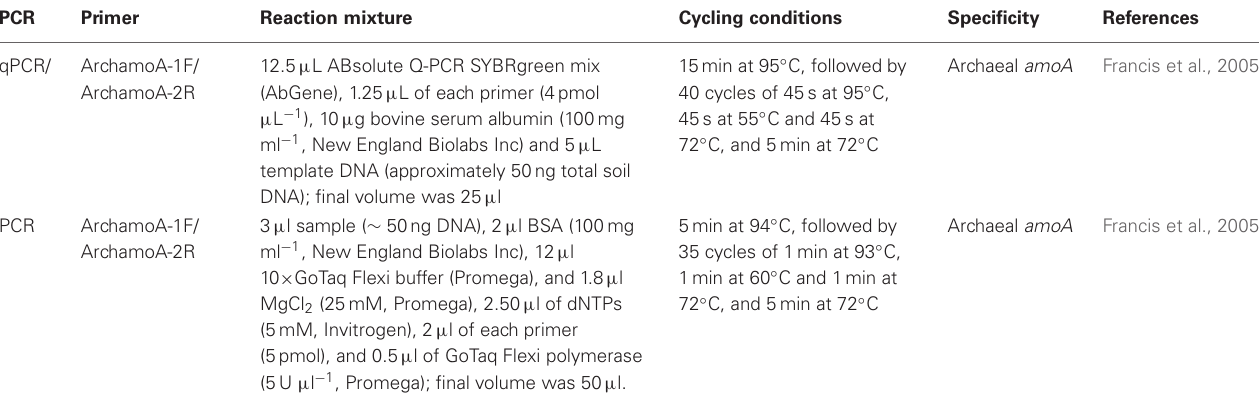
Table A1 | PCR primers and cycling conditions applied to amplify AOA.